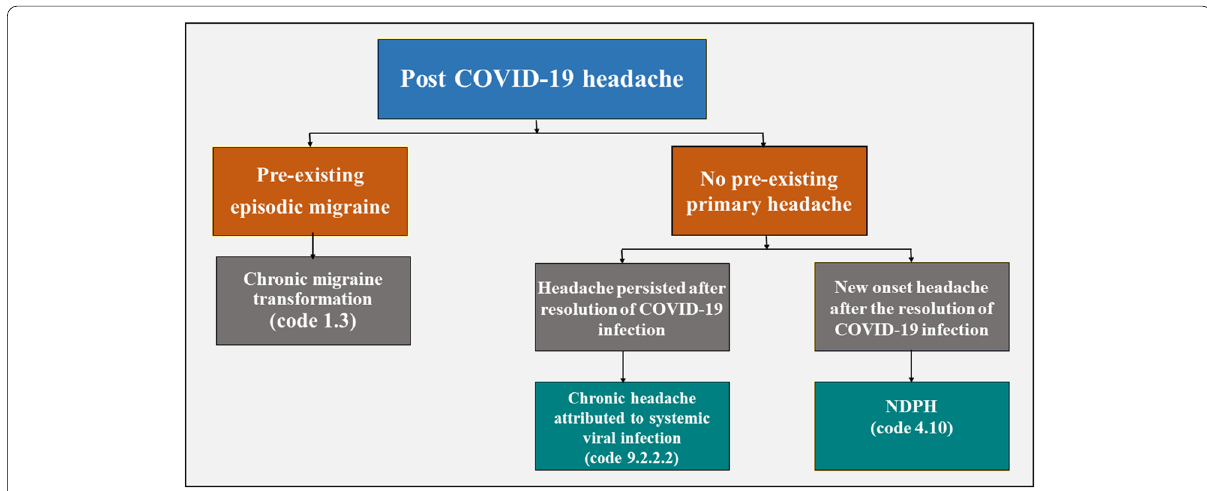
Fig. 2 Patterns of post‑COVID‑19